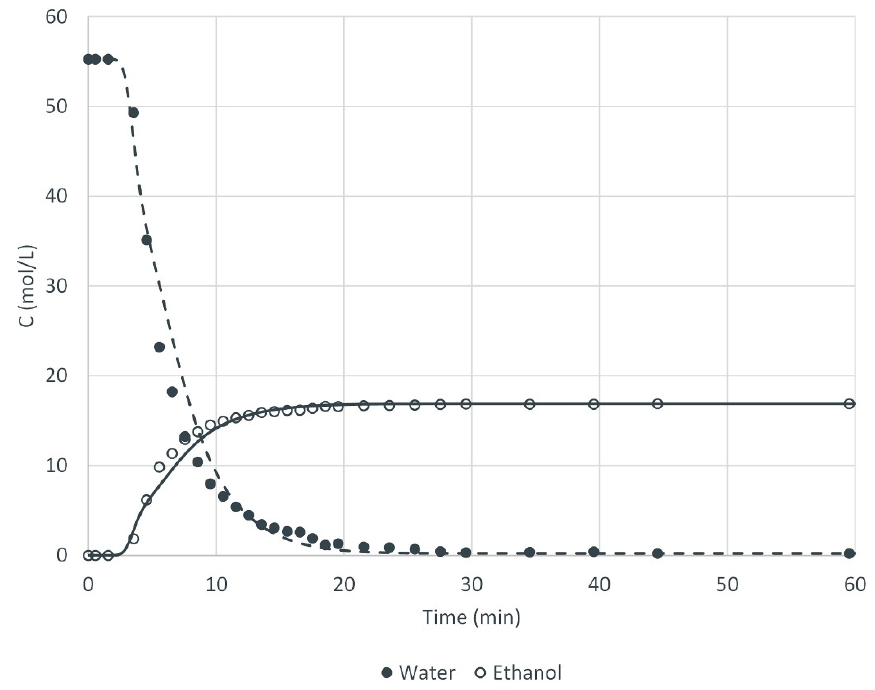
Figure 5. Breakthrough curve between ethanol and water experimental conditions provided in Table 2 for experiment 2 [22].